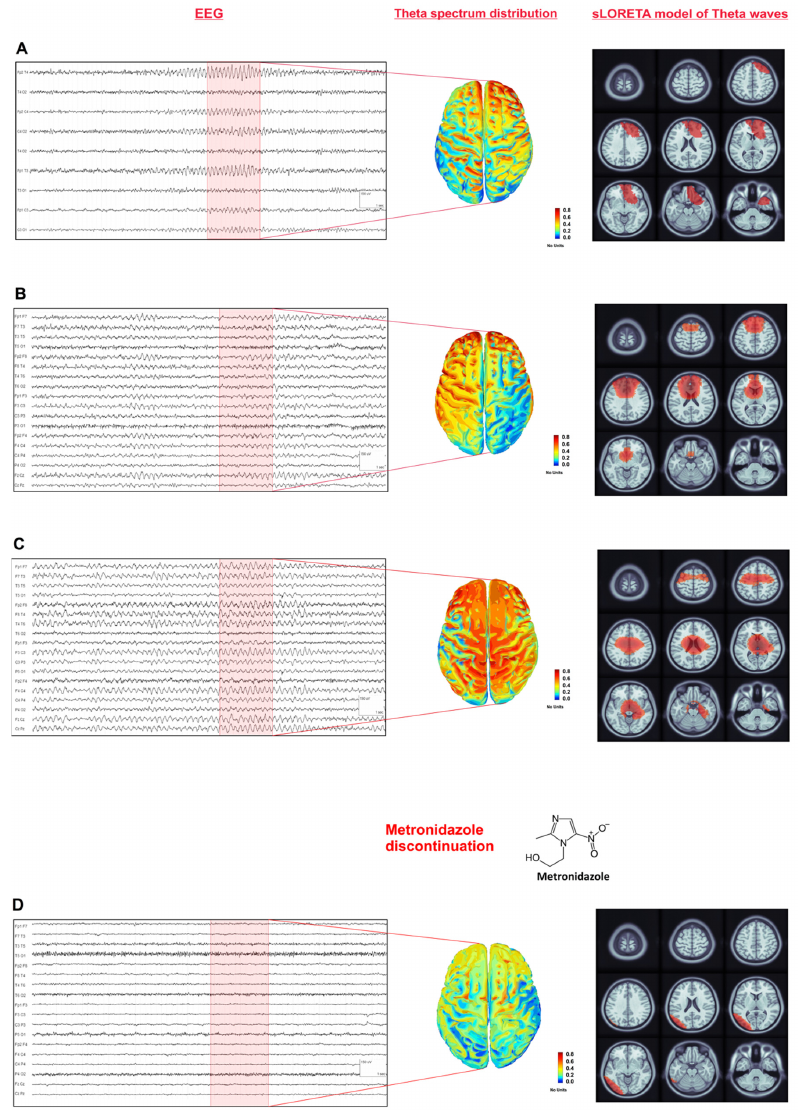
Figure 1. Standard 19-channel electroencephalography (EEG) recordings of our patient (high pass filter: 1.6 Hz; low pass filter: 50 Hz; left panel), standardized low-resolution brain electromagnetic tomography (sLORETA) distributed solution of normalized relative theta (5–7 Hz) power density at the cortical voxels (middle panel) and source analysis of averaged theta waves (right panel). LORETA computes 3D linear solutions for the EEG inverse problem within a 3-shell spherical head model including scalp, skull and brain compartments. ( A ) shows the EEG obtained after our first examination characterized by frequent and very brief runs of bilateral and symmetric monomorphic sharp theta activity over frontal regions. Serial EEGs, performed 8 ( B ) and 12 days ( C ) later, confirmed the presence of rhythmic monomorphic sharp theta activity, organized in more prolonged sequences. sLORETA distributed solution for theta frequency power spectrum confirms the anterior distribution of slow activity. sLORETA source analysis of averaged theta waves shows an anterior distribution of electrical generators for the first 2 EEGs as well ( A , B ); while the last EEG displays deeper electrical generators (bilateral thalami and subcortical white matter, ( C )) which may suggest the involvement of dentate-thalamo-cortical tracts. Values in this figure represent the relative power of each source. At each vertex of the cortex surface, the value between 0 and 1 indicates the contribution of the current frequency band to the total power in the signal. Panel ( D ) shows a 1-month follow-up EEG. No abnormalities are noticed. sLORETA solution shows normalization of the theta-band anterior distribution as well. sLORETA solution was performed using the Brainstorm toolbox for Matlab and age-appropriate head templates [7]. The left side of cortical images and 2D magnetic resonance imaging (MRI) corresponds to the left